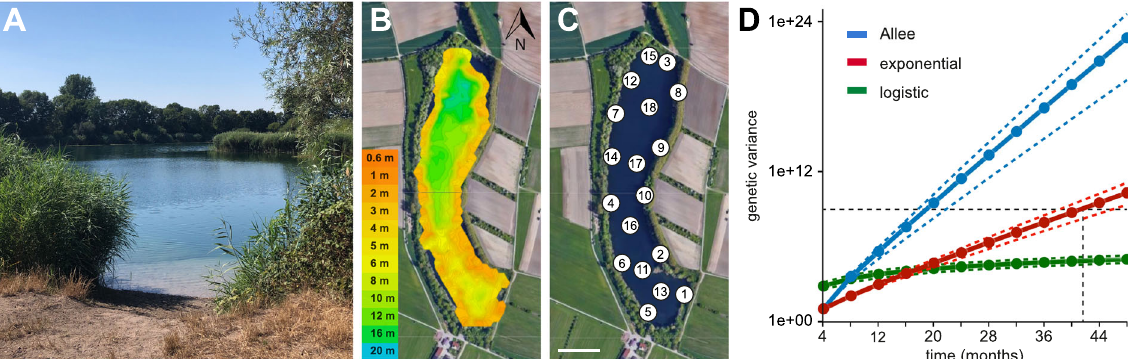
Fig. 5 Marbled cray fi sh population size estimate and growth simulation at Lake Reilingen. A Picture of Lake Reilingen, a small (9 ha) lake in Germany with an established marbled cray fi sh population. Picture provided by Sina Tönges. B Bathymetric map of Lake Reilingen, generated with Deeper Smart Sonar software. Water depths are indicated by color, North is indicated by the arrowhead. C Positions of the 18 traps used for the population size estimate. Scale bar: 100 m. Map data: Google, Maxar Technologies. D Marbled cray fi sh population growth kinetics simulations. The horizontal dashed line represents the genetic variability of 1e + 09 in the current Lake Reilingen population. Colored lines show the predicted genetic variability for exponential, logistic, and Allee growth models (see “ Methods ” for details). Dashed colored lines indicate error